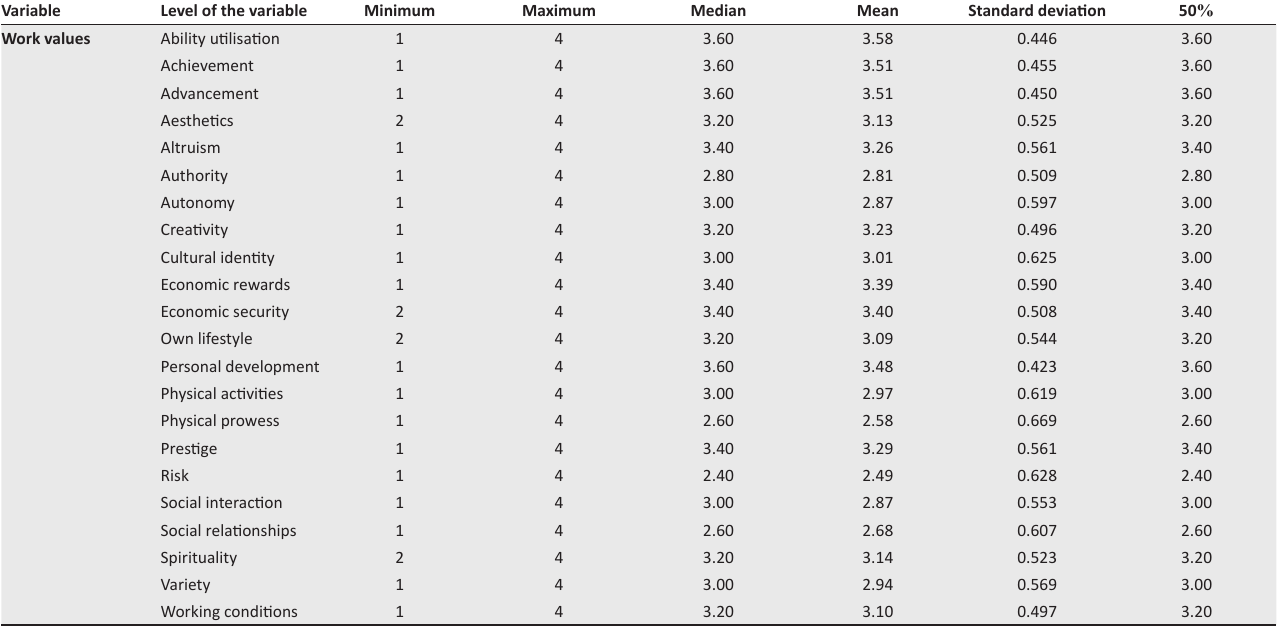
TABLE 1: Measures of central tendency for Generation Y with regard to work values.